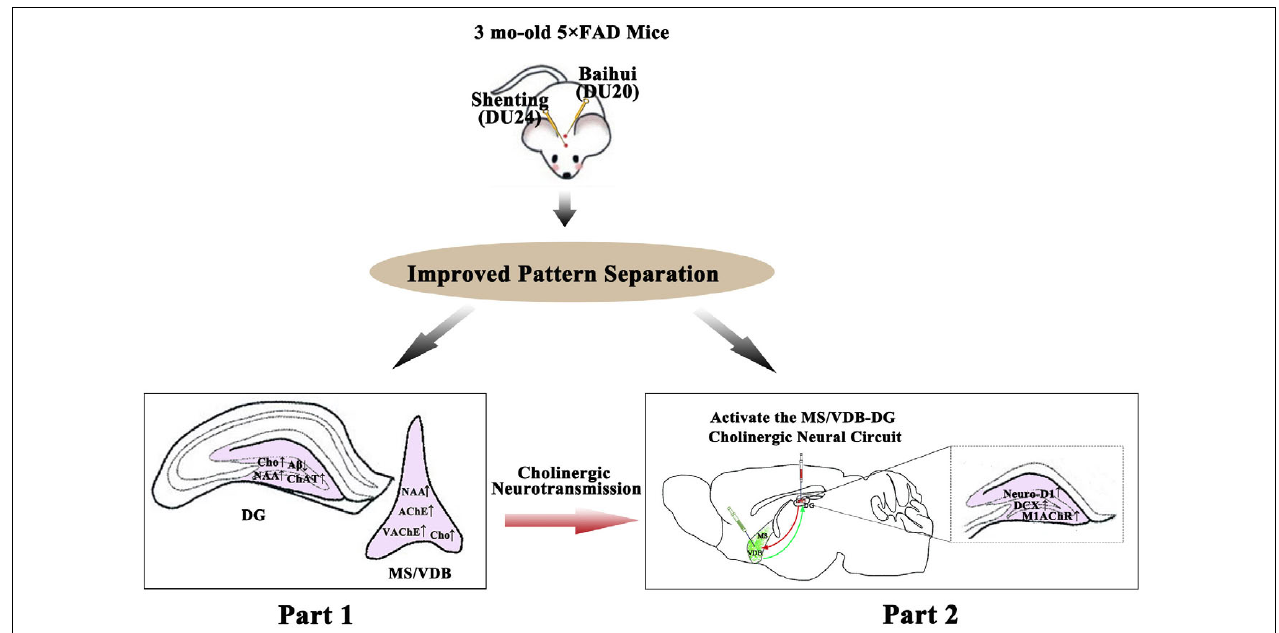
FIGURE 14 | Summary drawing of the experimental findings. The present study included two parts: Baihui (DU20) and Shenting (DU24) acupoints with EA stimulation in 3-month-old 5 × FAD mice (upper) , and the pattern separation ability was improved after EA treatment (middle) . It was found that the alteration of the cholinergic system in MS/VDB and DG (left, bottom) , the increased of the M1 muscarinic receptors and hippocampal neurogenesis in the DG via activating of the MS/VDB-DG cholinergic neural circuit (right, bottom) . EA treatment normalized the pattern separation performance in FAD mice, which was related to activating the MS/VDB-DG neural circuit, regulating the M1 muscarinic receptors and promoting hippocampal neurogenesis in